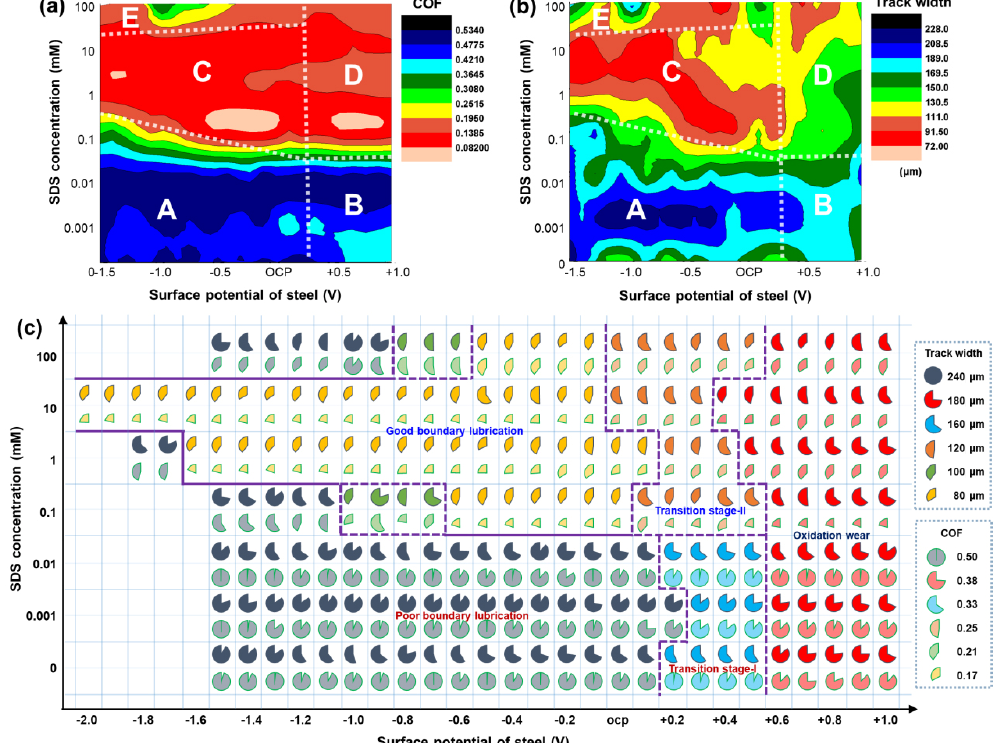
Fig. 2 Friction and wear maps of 304/304 tribo-pairs lubricated with various concentrations of SDS aqueous solutions under different surface potentials. (a) COFs map and (b) track widths map under different surface potentials and SDS concentrations drawn by Origin, (c) friction and wear map drawn by Power